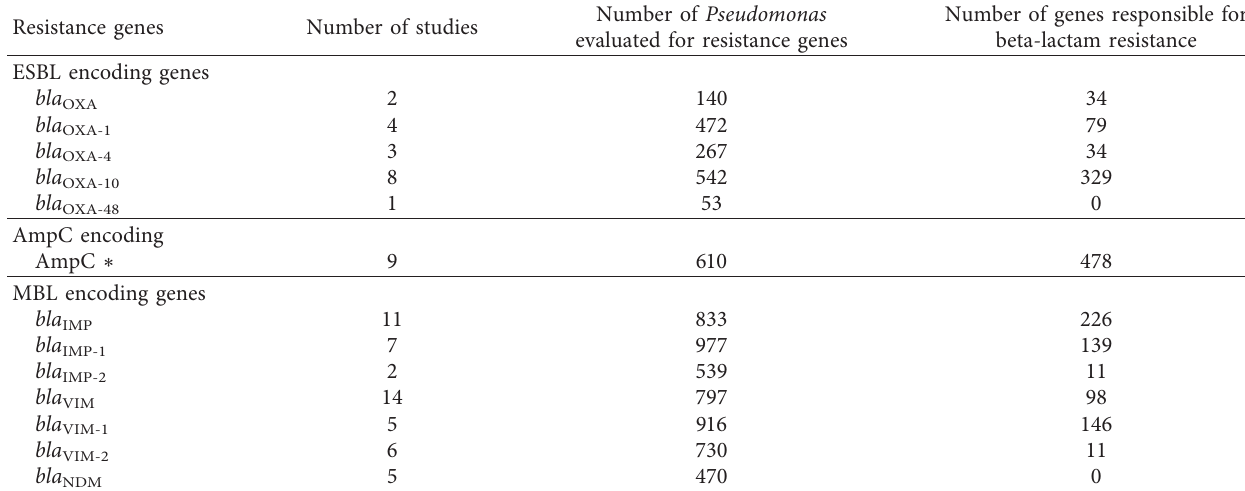
Table 2: Mechanisms of β -lactams resistance (except Ambler class A-associated